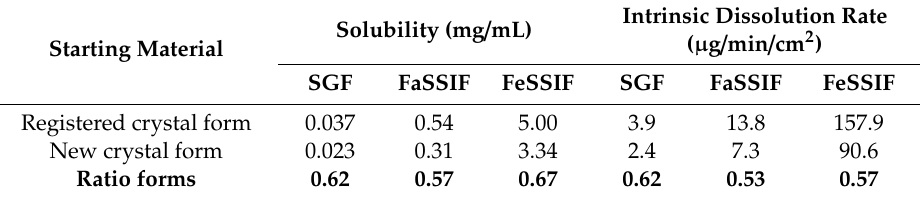
Table 1. Comparison of the physico-chemical parameters of JNJ-1 and the newly isolated crystal form. Intrinsic Dissolution Solubility (mg / mL) Starting Material